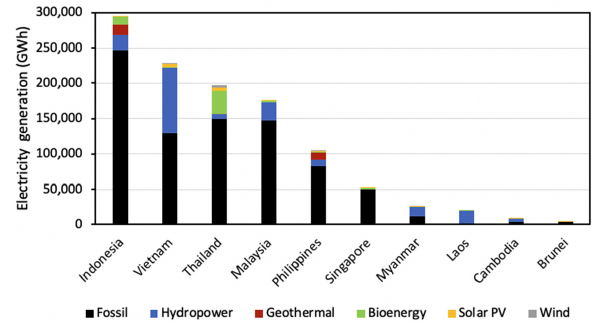
Figure 17. ASEAN electricity generation by type in 2019 [22] .